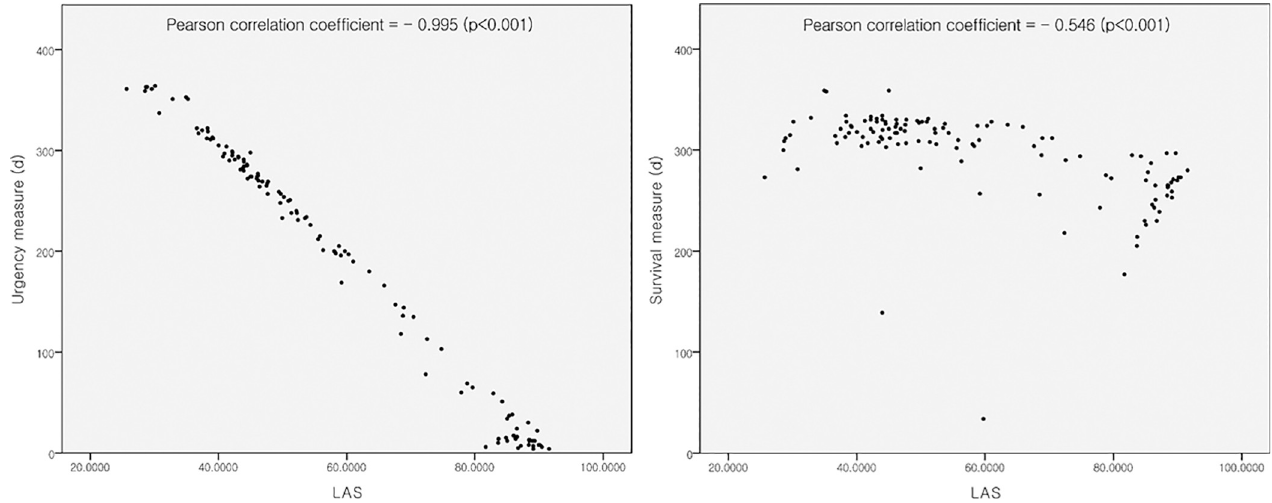
Fig 2. Correlations between the lung allocation score, urgency measure, and survival measure. Abbreviation: LAS, lung allocation